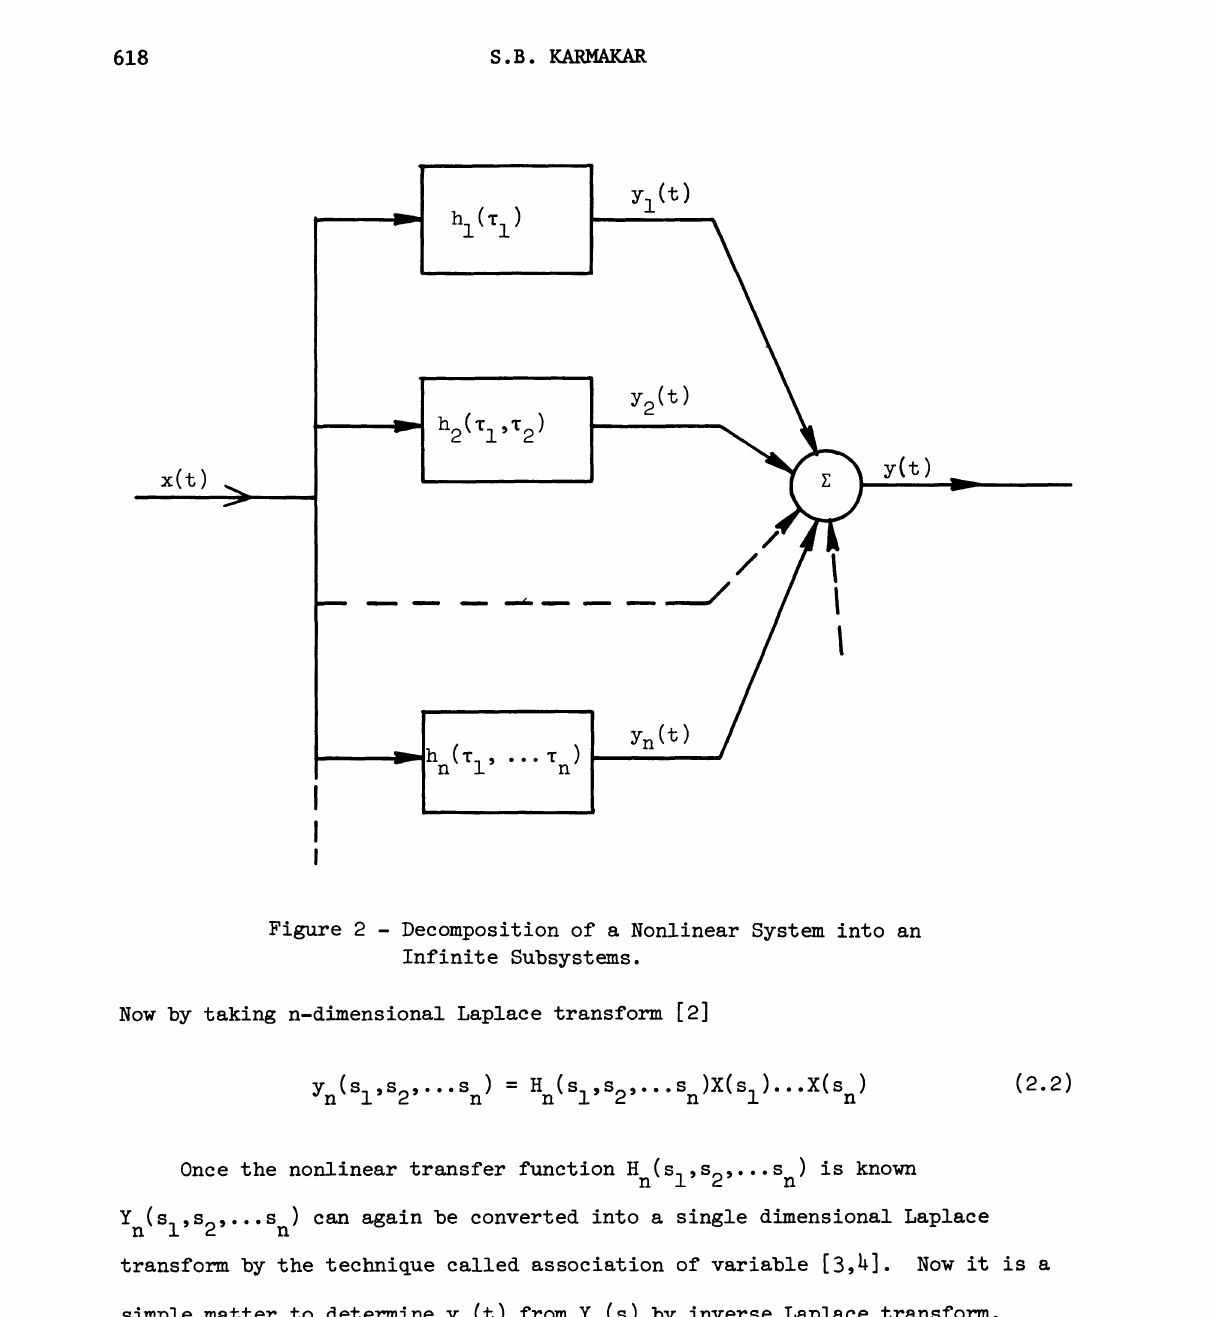
Figure 2 Decomposition of a Nonlinear System into an Infinite